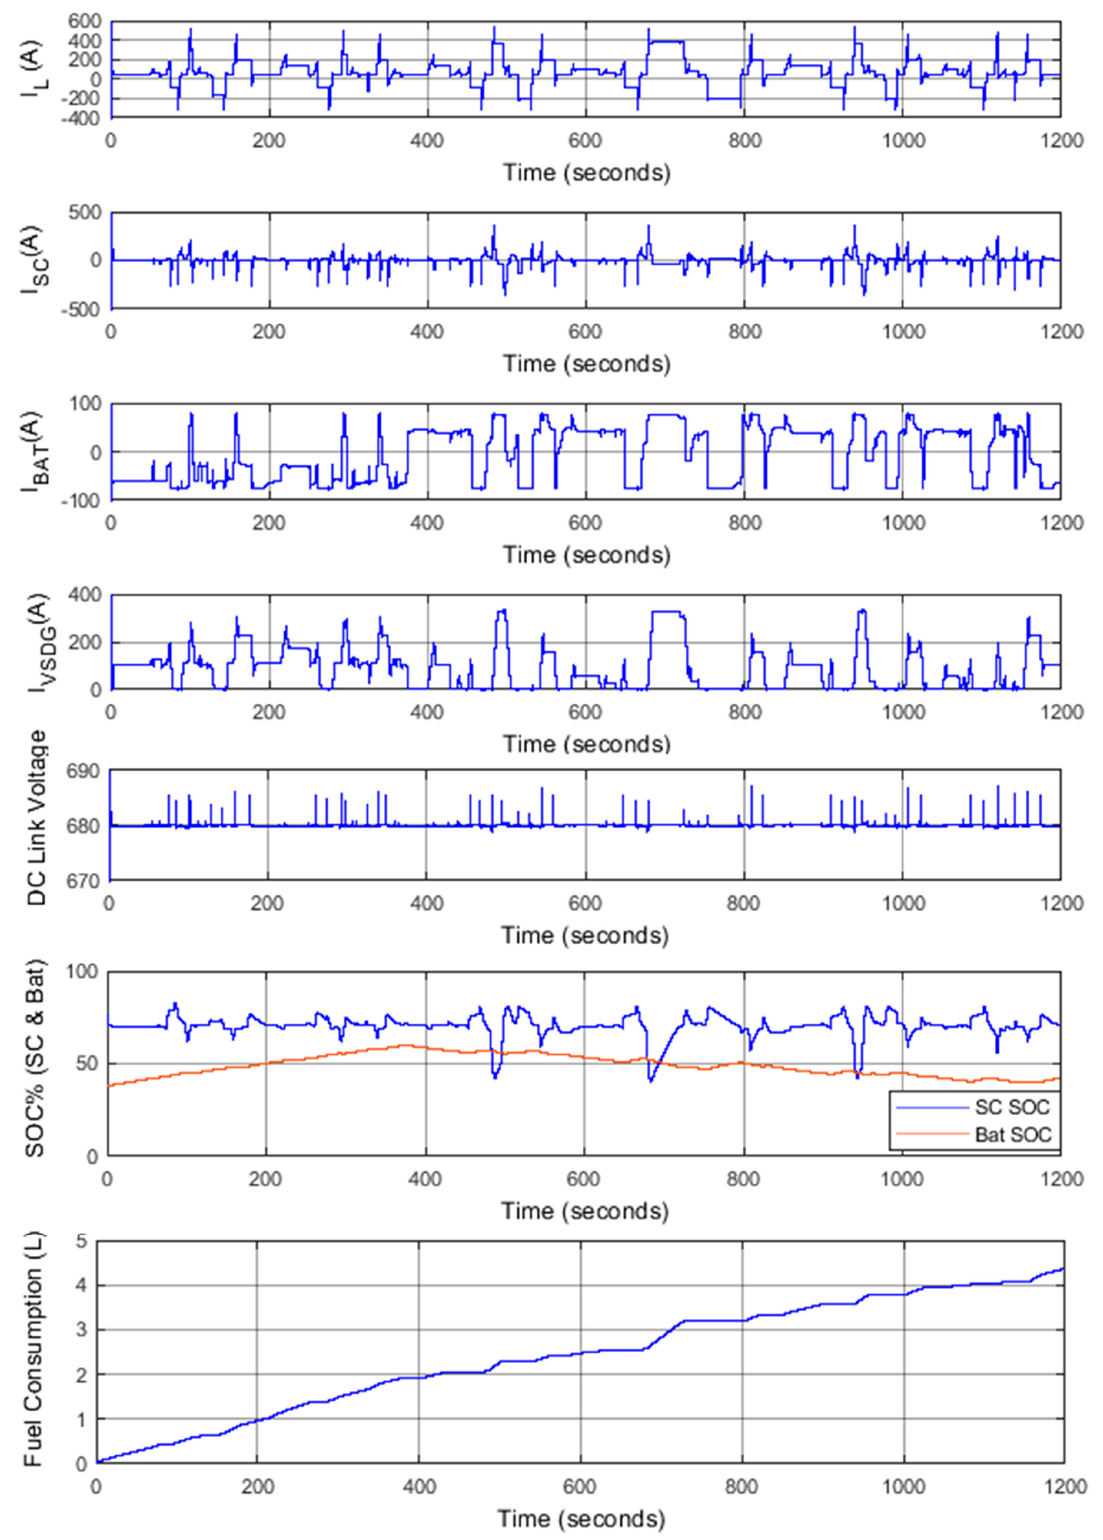
Figure 13. SOC and current variations of Case 2